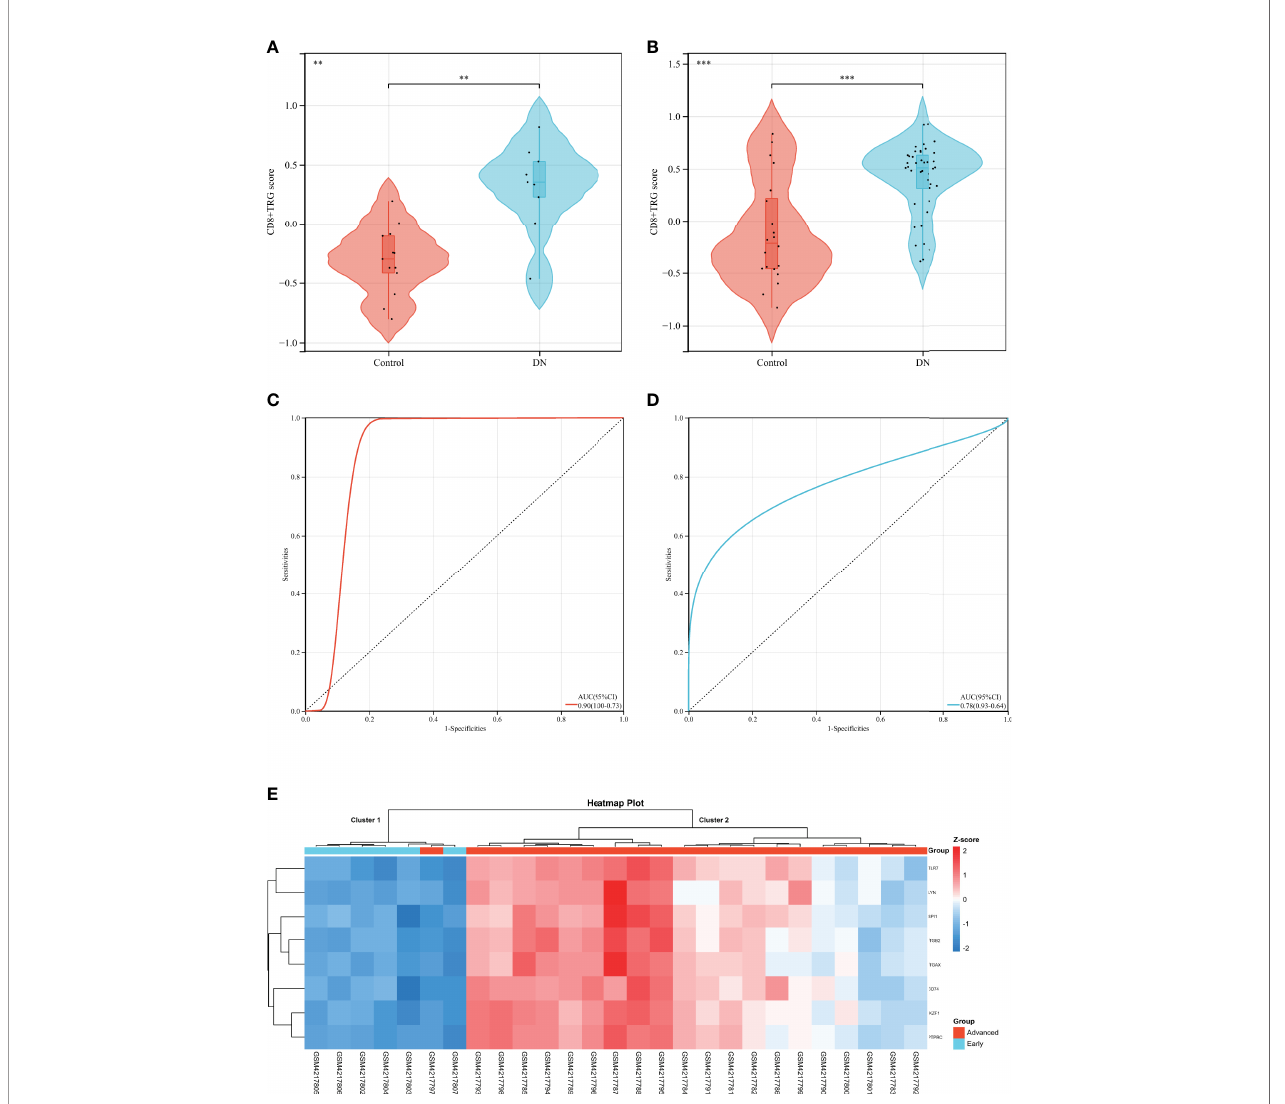
FIGURE 6 | Diagnostic ef fi cacy of CD8+TRG score in patients with DN. (A, B) Comparison of CD8+TRG scores between normal and DN in GSE30528 and GSE96804 datasets. (C, D) Receiver operating characteristic curve for diagnosis of DN plotted with CD8+TRG score in GSE30528 and GSE96804 datasets. (E) Unsupervised hierarchical clustering heat map of Hub DECD8+TRGs, a set of eight genes in GSE142025, showing z-score differences between early and advanced DN. AUC, the area under the curve. ** represents p < 0.01 and *** means p <